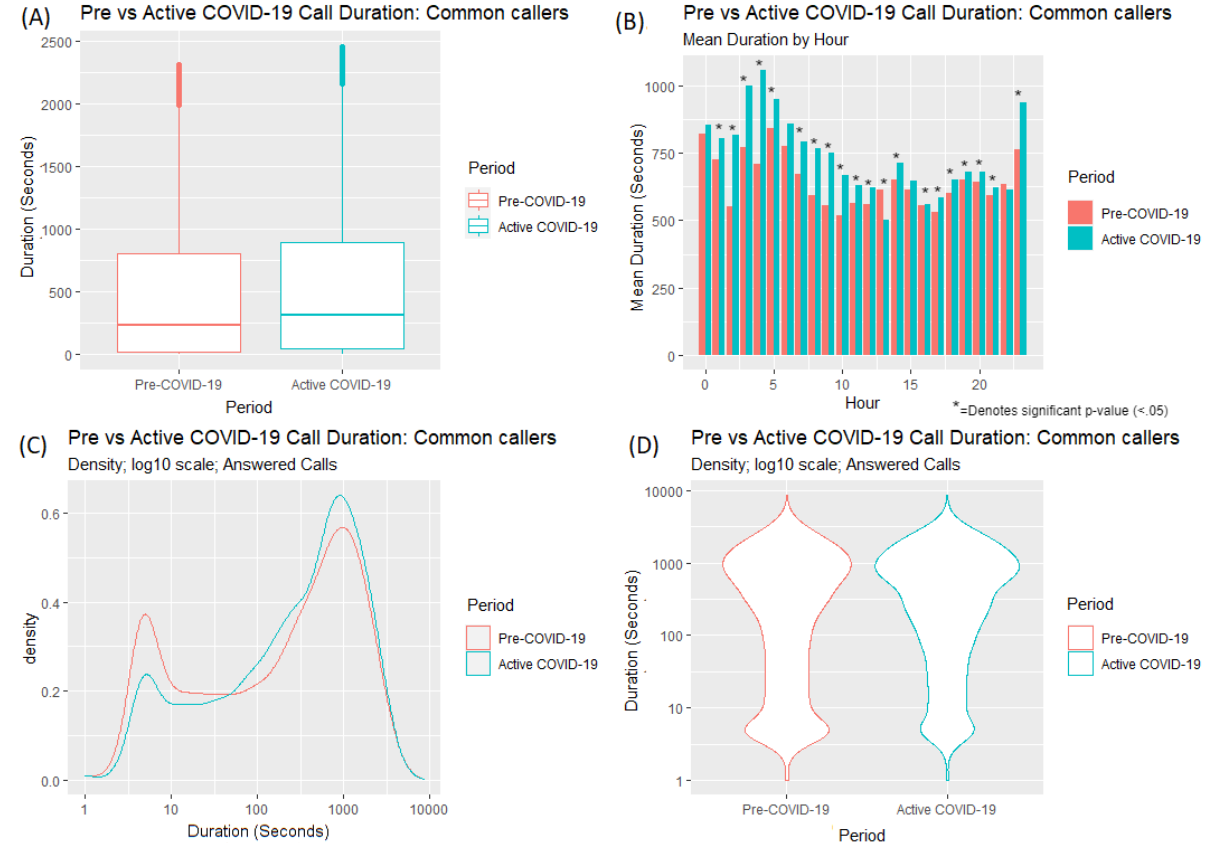
Figure 6. Differences in (A) call duration for answered calls by common callers in the Pre–COVID-19 and Active COVID-19 periods; (B) mean duration of calls by hour of day; and (C,D) density of call duration.